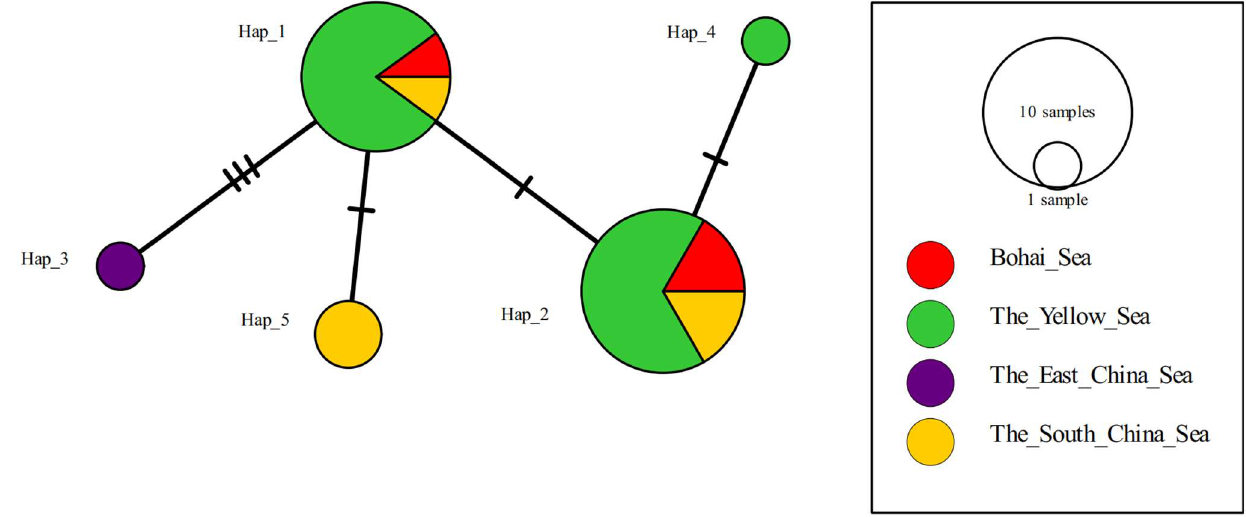
Figure 5. Network diagram of the U. meridionalis haplotypes derived from the ITS sequences.